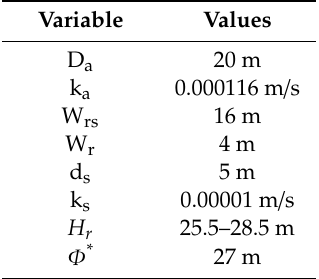
Table 1. Parameters of river sediments, riverbed, and riparian aquifer in the exemplary